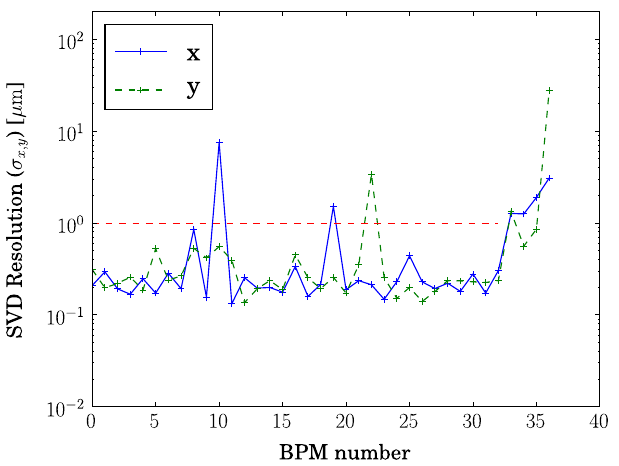
FIG. 18. Resolution of all of the BPMs along the beam line using data from February 2011.